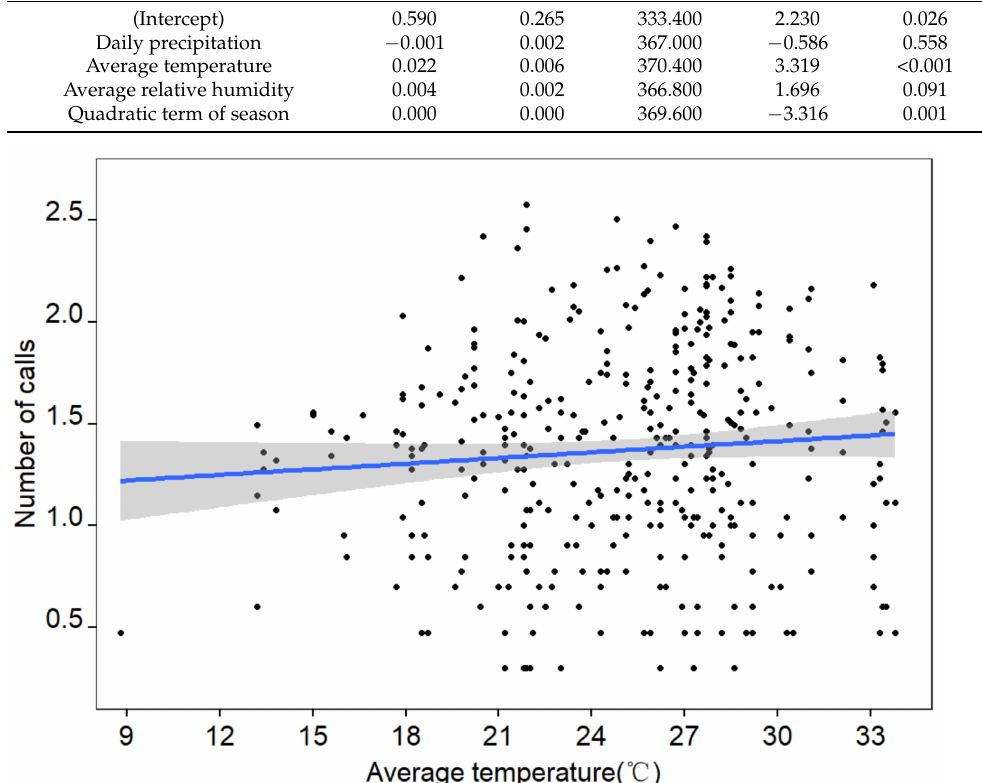
Figure 6. Scatterplot showing the variation in the daily vocal activity (after log-10 transformation) of the Oriental Turtle Dove as a function of the daily average temperature during the period 6 April 2019 to 6 October 2019. The linear regression line is shown in blue, and the corresponding 95% confidence intervals in